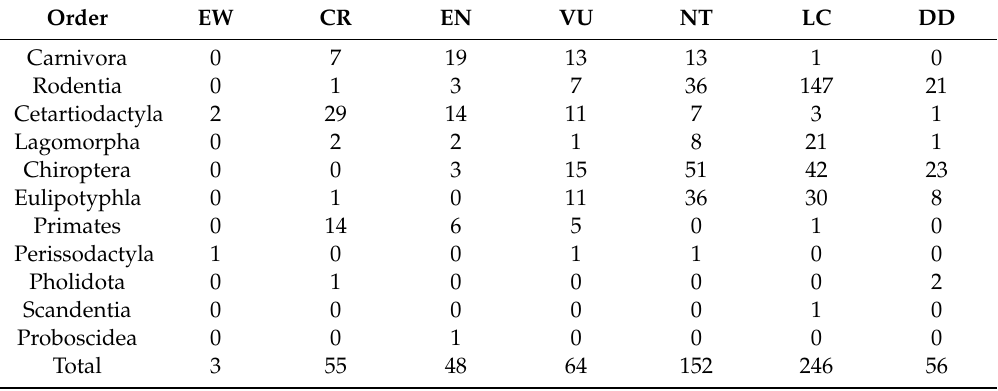
Table 2. Regional Red List status of different mammalian orders of China. The categories are Extinct in the wild (EW), Critically Endangered (CR), Endangered (EN), Vulnerable (VU), Near Threatened (NT), Least Concern (LC), and Data Deficient (DD).